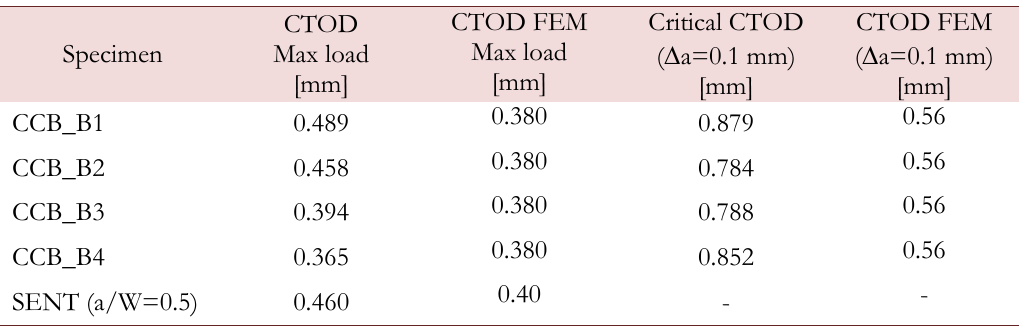
Table 4: Summary of CTOD measurement for CCB and